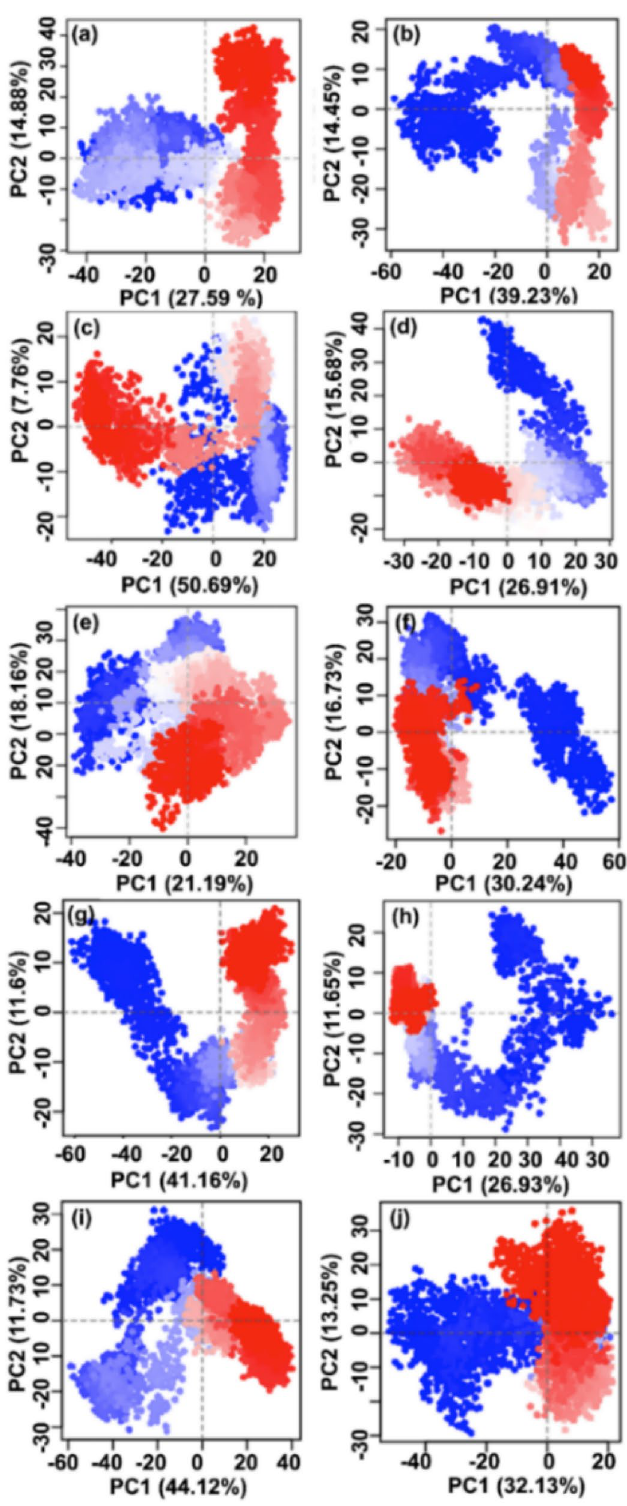
Figure 8. Score plots for the computed principal components (PC1 vs PC2) from 100 ns MD simulation trajectories of Sirt2 docked with selected drugs, i.e. ( a ) Canagliflozin, ( b ) Flibanserin, ( c ) Ezetimibe, ( d ) Pimozide, ( e ) Fluphenazine, ( f ) Droperidol, ( g ) Osimertinib, ( h ) Pioglitazone, ( i ) Formoterol, and ( j ) Nintedanib. The incessant color scale from blue to white to red directs the periodic jumps between the structural poses of Sirt2 as a function of the 100 ns simulation interval. Images has been rendered in Bio3d package (Released version 2.4-1; URL: http:// thegr antlab. org/ bio3d/) 52 under R environment (R version 4.0.4; URL: http:// mirror. fcaglp. unlp. edu. ar/ CRAN/) 53